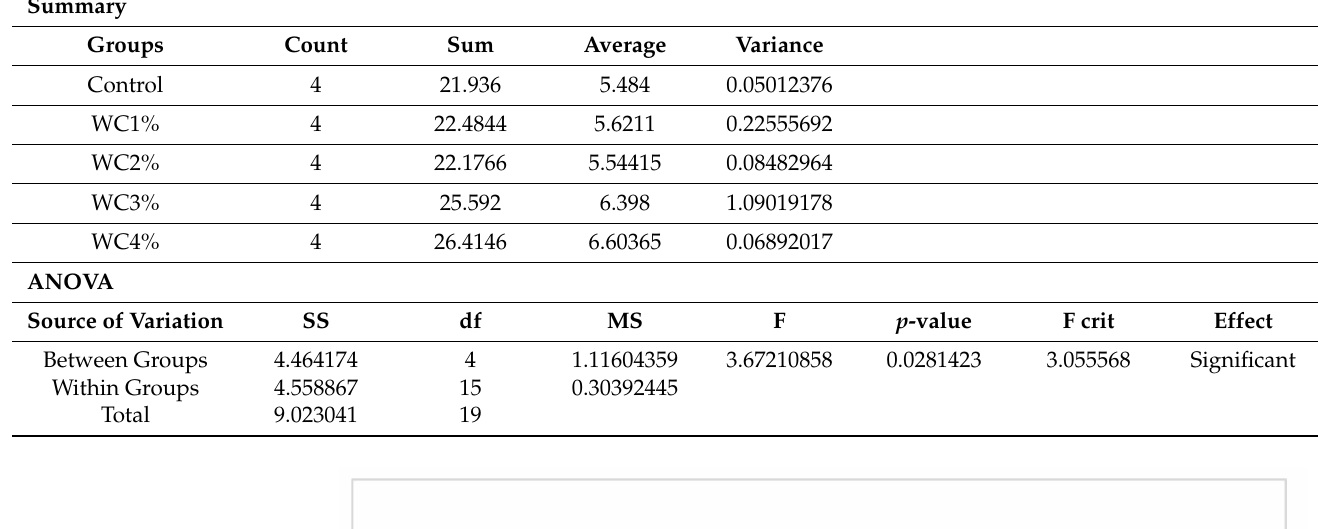
Table 5. ANOVA for Flexural Strength Variation with the increase in SiC percentage.